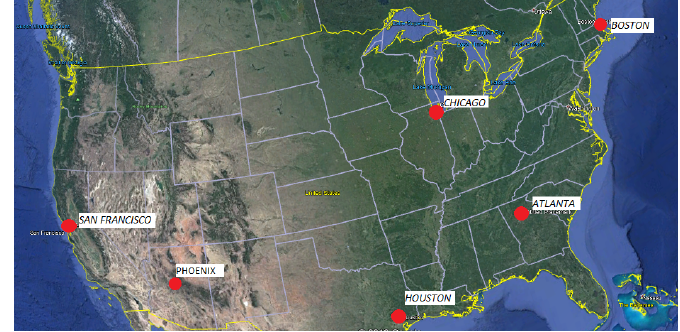
Figure 2. The six investigated U.S. Metropolitan Areas